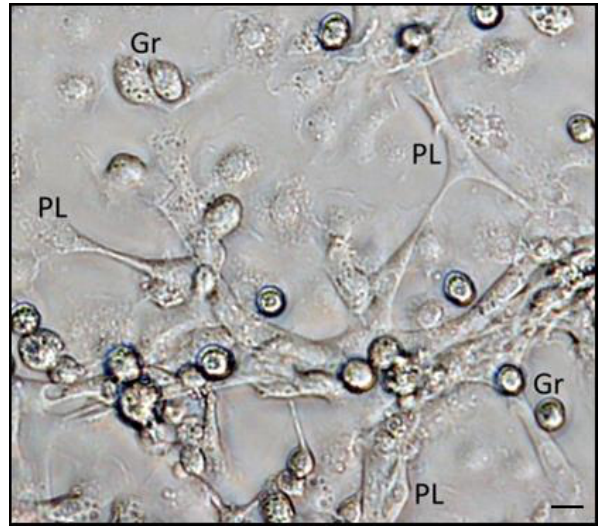
Figure 9. Nomarski Interference Contrast (NIC) micrograph of a culture of G. mellonella hemocytes: Adherent plasmatocytes (PL) and many reacted and not-reacted granulocytes (Gr) are observable. Bar = 50 µ m, (Unpublished micrograph by Brivio [86]).